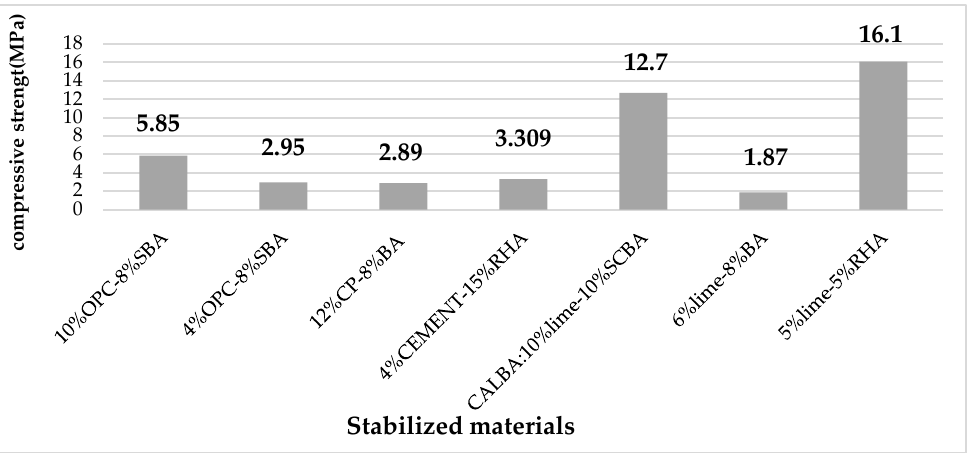
Figure 8. Compressive strength for unfired clay bricks stabilized with lignocellulosic biomass ash and lime/Cement: 10% OPC-8% SBA [77], 4% OPC-8% SBA [77], 12% CP-8% BA [78], 4% Cement-15% RHA [79], 10% lime-10% SCBA [80], 6% lime-8% BA [81], 5% lime-5% RHA [84].